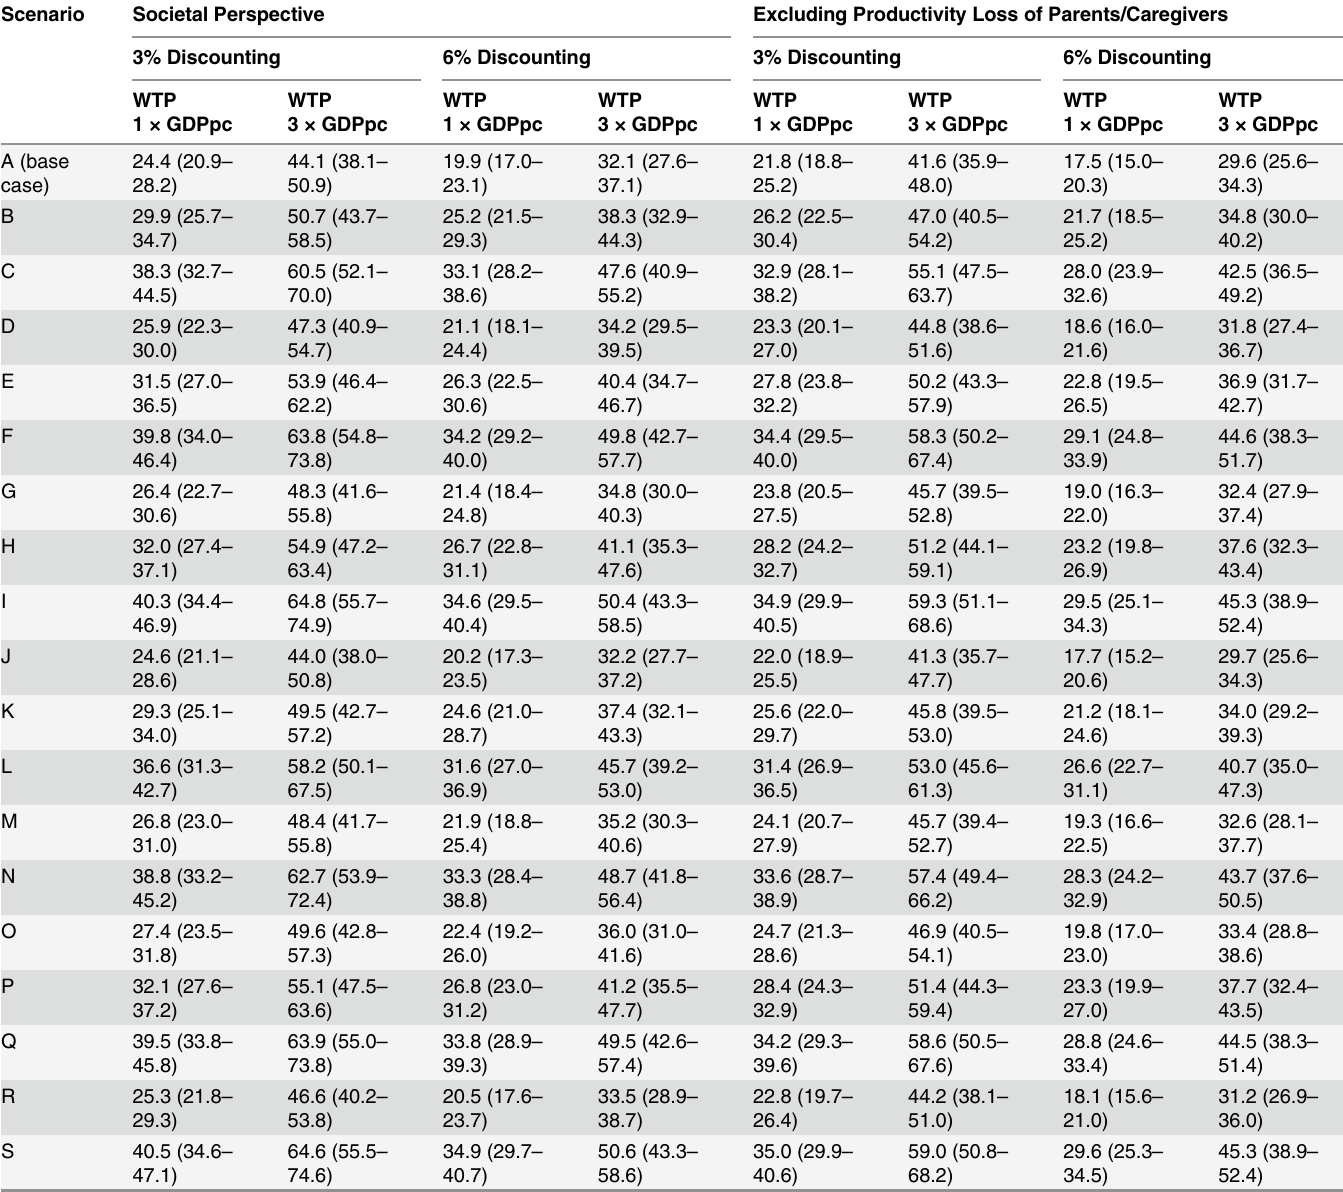
Table 3. Cost-effectiveness ceiling on effective vaccine cost if the proportion of EV71-HFMD cases registered by national surveillance was the same as that observed in the three EV71 vaccine